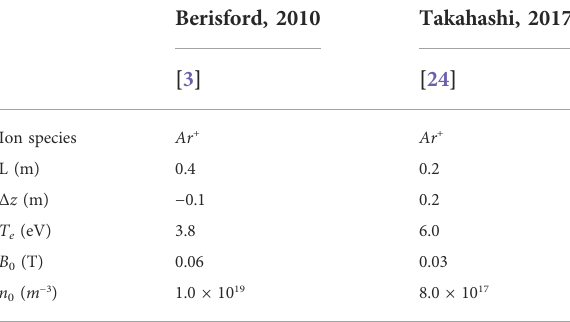
TABLE 3 Experimental parameters obtained for the data sets used in Figure 4, for the validation of Ahedo ’ s axial model in the asymptotic case [12].